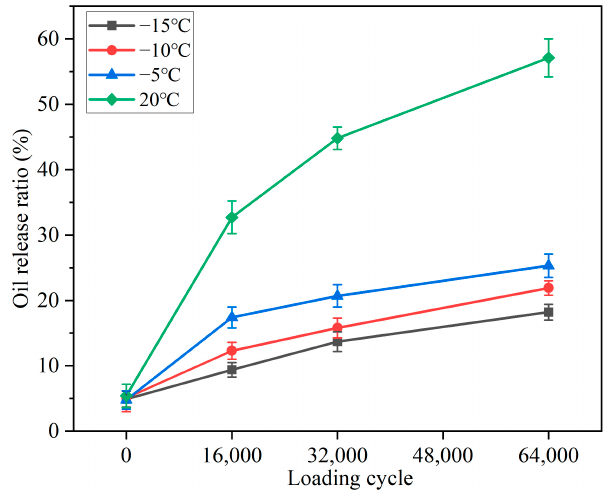
Figure 9. Oil release ratios of Ca alginate capsules within asphalt concrete after loading at different service temperatures.